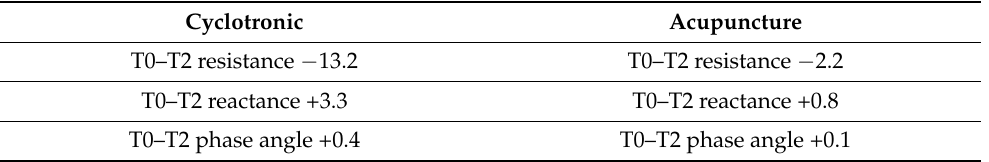
Table 8. Cyclotron vs. acupuncture—comparison of deltas of the T0 and T2 average values of resistance, reactance, and phase